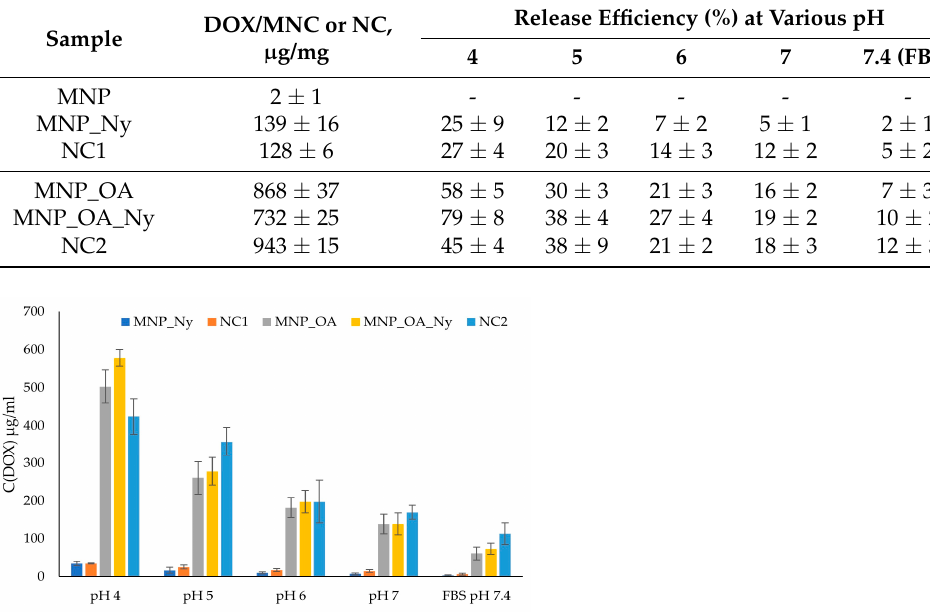
Figure 6. DOX release results after 3 h incubation at various pH and in FBS (pH 7.4).